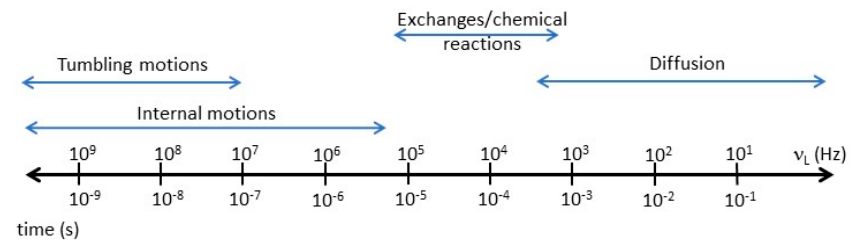
Figure 1. Time scale of molecular motions unveiled by different NMR techniques. The top side of the scale indicates the strength of the applied magnetic field in terms of proton Larmor frequency.